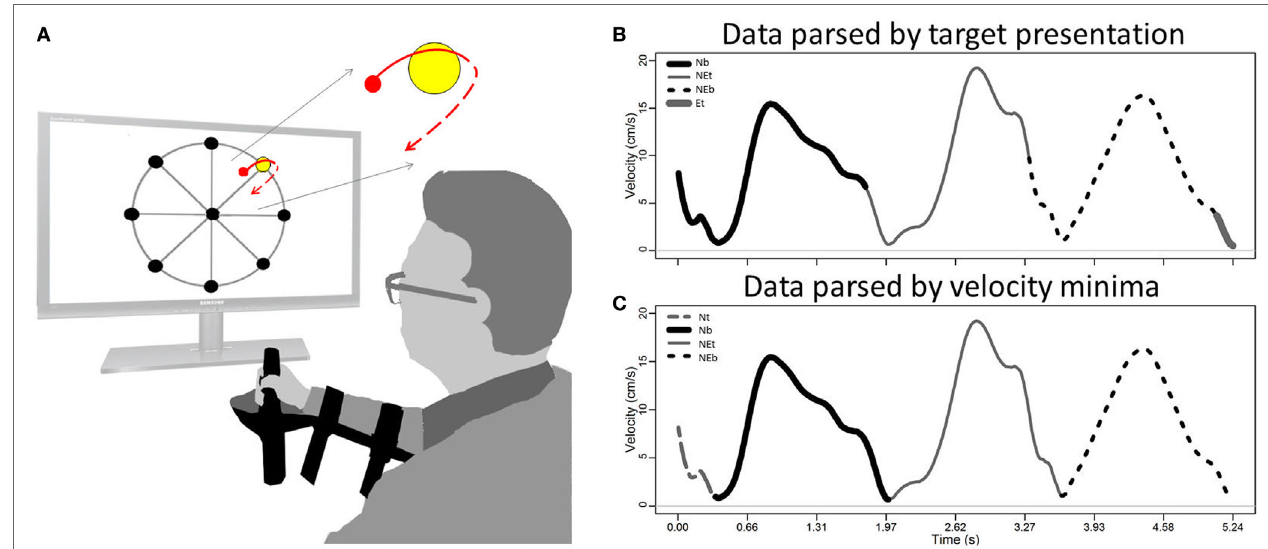
FiguRe 1 | Schematic of subject performing a robot-driven multi-target task (A) ; and kinematic record (velocity versus time) of data collected through serial targets (B,C) . Raw data obtained from the robot may not coincide with the subject’s transition between targets (B) ; the time-series may require conditioning so that each movement is bounded by a local minimum of velocity (C) . Direction annotations in figure legends are Nt = North toward (from center target toward North target), Nb = North back (from North target back to center target), NEt = Northeast toward (toward the NE target), NEb = Northeast back, and Et = East toward; see Section “Patient Population and Protocol.”